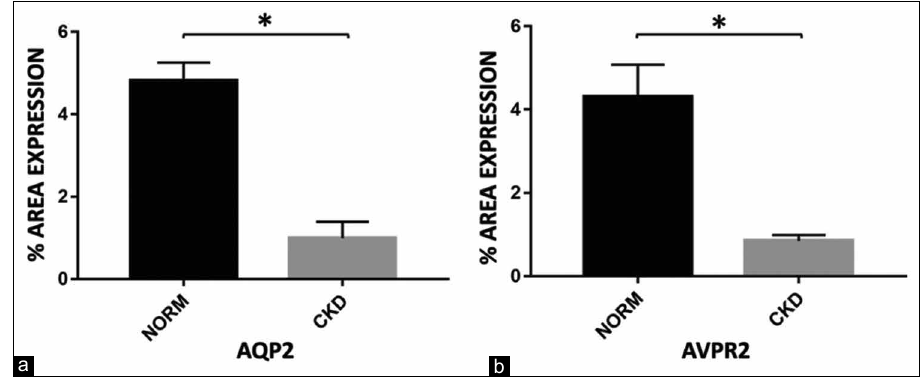
Figure-4: (a and b) Semi-quantitative analysis of aquaporin (AQP) 2 and arginine vasopressin receptor (AVPR) 2 immunostaining in canines with chronic kidney disease (CKD) and normal kidney (NORM). The Mann–Whitney U-test: Values are expressed as mean±SEM, with *p<0.001 significance level. Semi-quantitative analysis of CKD revealed a significant decrease in the percentage of protein expression in AQP2 and